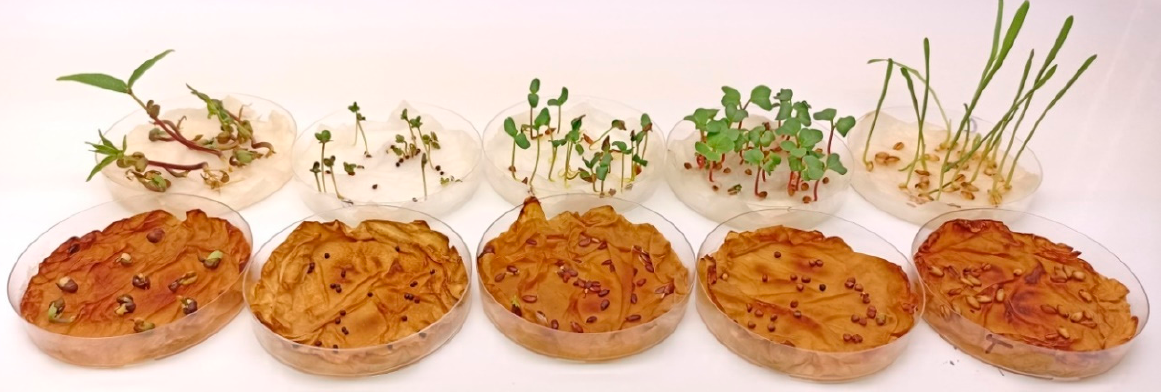
Figure 2. Allelopathic effects of alfalfa seed exudates on various plant species after 10 days. Alfalfa seedling exudate signi fi cantly suppressed the seedling growth of all tested plants. 2.3. Identi fi cation of the Substances Responsible for the Allelopathic E ff ect in Alfalfa Seeds Exudates